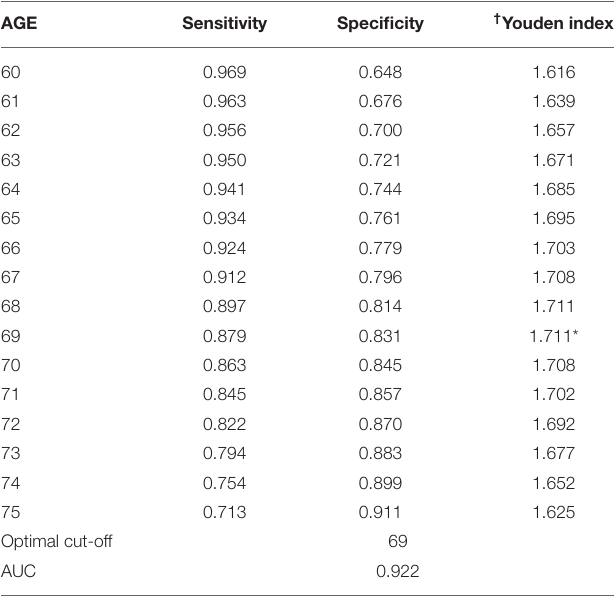
TABLE 2 | Sensitivity and specificity in predicting AD by the different age cut-off. AGE Sensitivity